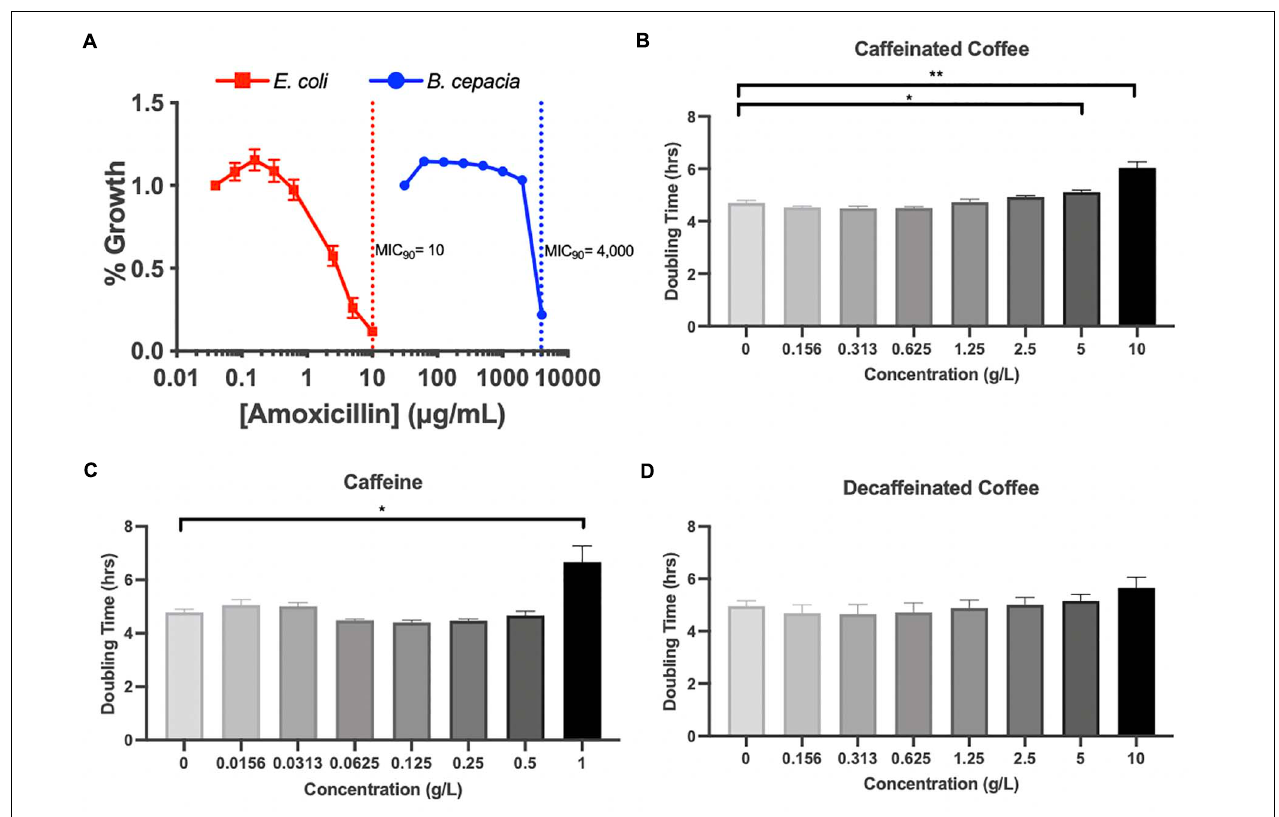
FIGURE 5 | (A) MIC assessment of B. cepacia , E. coli with amoxicillin in TSB or MGAM, respectively, containing varying concentrations of amoxicillin. MIC 90 indicated by dotted lines. Doubling time calculated from growth curves of B. cepacia cultured in TSB with varying concentrations of (B) caffeinated coffee, (C) caffeine, and (D) decaffeinated coffee; n = 3 (*, 0.01 < P < 0.05; **, 0.001 < P < 0.01; unpaired t